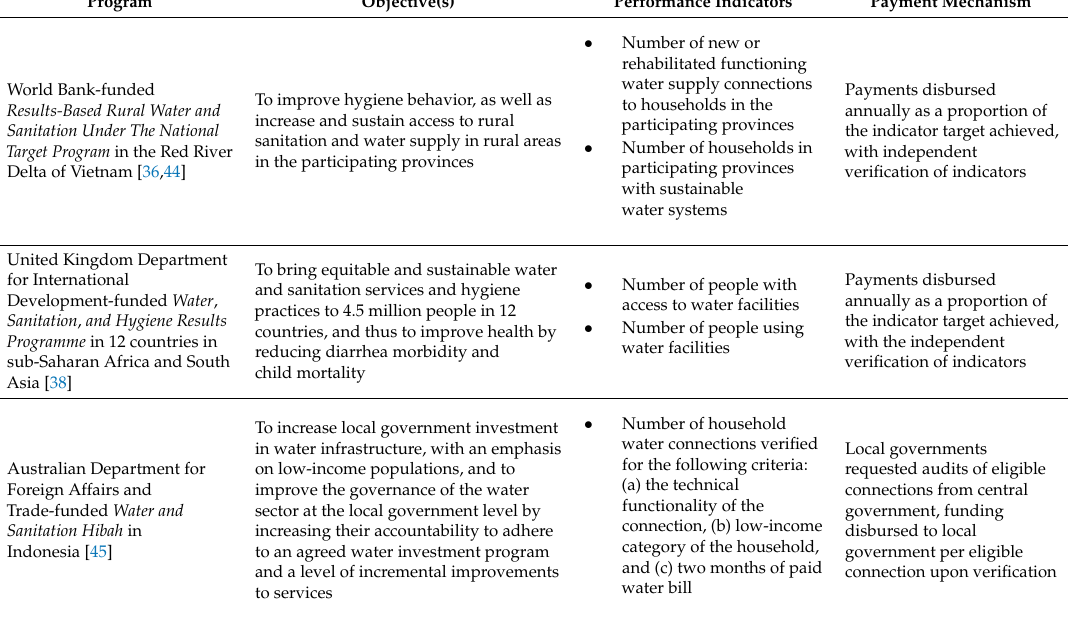
Table 1. Pay-for-performance water programs and their objectives, select performance indicators, and associated payment